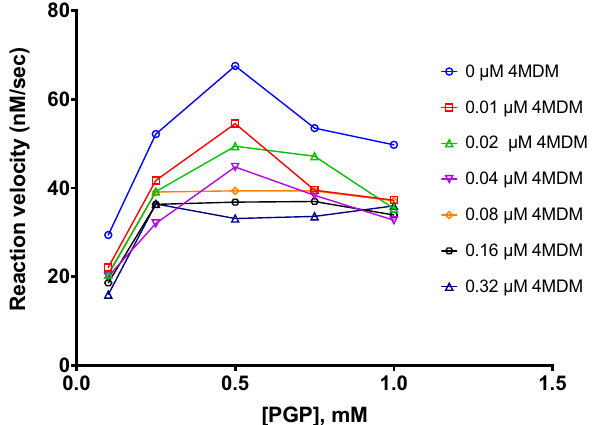
Figure 3. Reaction velocity plot of LTA 4 H-mediated hydrolysis of PGP. Reaction velocity plot showing the modulation of PGP-induced (substrate-induced) inhibition in the presence of 4MDM. Each sample was prepared in twenty replicates (n = 20), and the coefficient of variation is within 5%. Data shown in the figure is the average of twenty replicates.